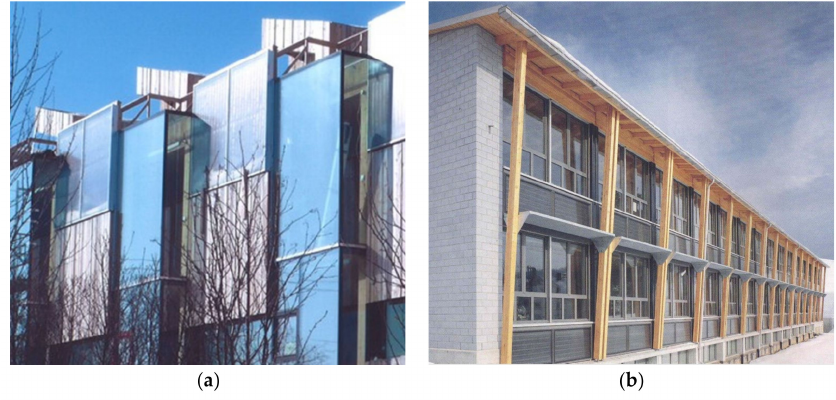
Figure 3. Integration on façade with glazed flat plate collectors: ( a ) residential complex in Storelva-Tromsoe and ( b ) school building in Geis, Switzerland.